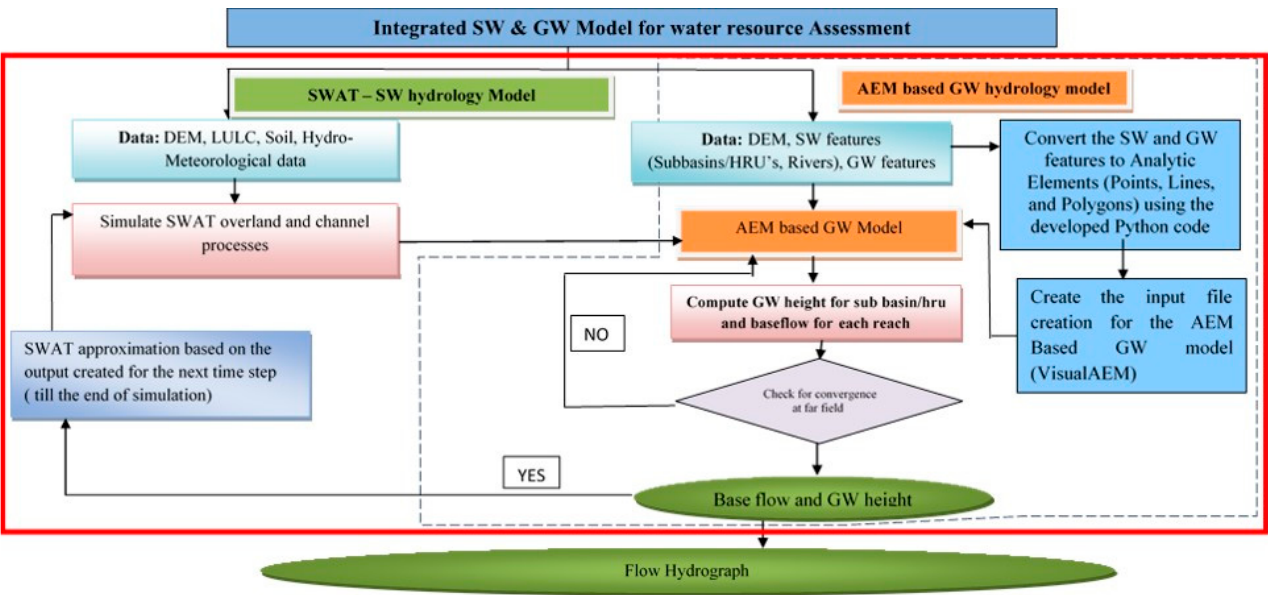
Figure 1. Flow chart explaining the components involved in the integrated SWAT-AEM.